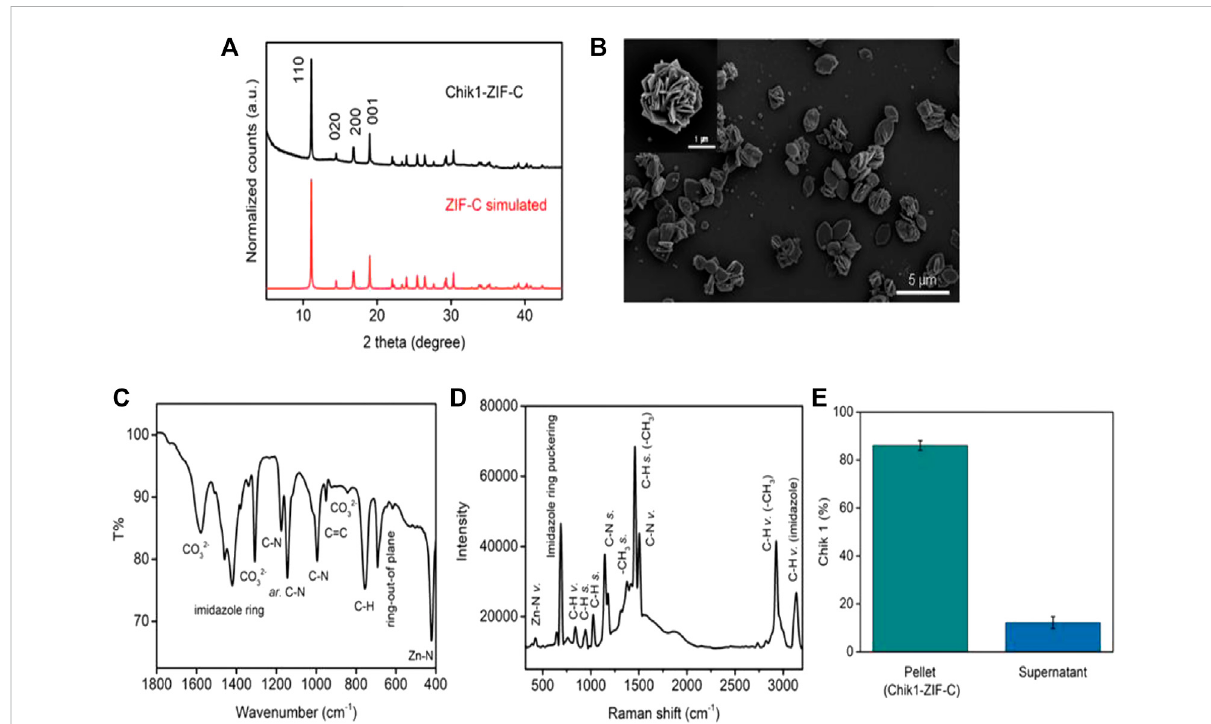
FIGURE 1 CharacterizationofChik1-ZIF-C. (A) XRDofChik1-ZIF-CwascomparedwithsimulatedZIF-C; (B) morphologywasrevealedbySEM;functional chemicalgroupsandsurfacecompositionwerestudiedby (C) FT-IRand (D) Ramanspectroscopy; (E) quanti fi cationofencapsulatedChik1sequence within ZIF-C MOF